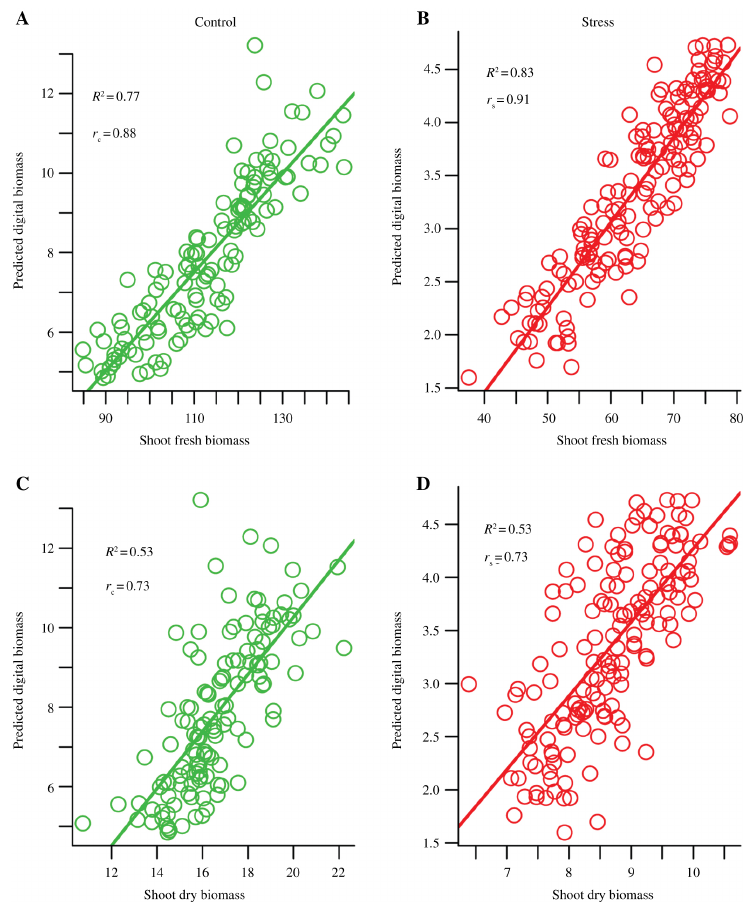
Figure 4: Correlation between image-derived predicted biomass and manually measured biomass. Scatter plots of image- derived predicted biomass with manual measurements. The manual measurements include (A,B) shoot fresh biomass (SFW) and (C,D) shoot dry biomass (SDW) when plants were harvested at day 58. Prediction performance according to the plant age can be seen graphically in the bar plots of Figure 5 where average biomass estimation error is higher when plant age is 12 – 26 days. The standard error (SE) is also much higher in this time period. The estimation error gradually decreases as the plant age increases with smaller SE (Figure 5). In our study, when the plant age is between 27 and 58 days, the proposed model provides more accurate inference about digital biomass. Digital biomass estimation error is significantly smaller at the age 45 – 58 days on average. These results proved that the better prediction of digital biomass from images is also depending on plant age. Another observation is that the prediction error of control plants is smaller than stress plants in all cases (Figure